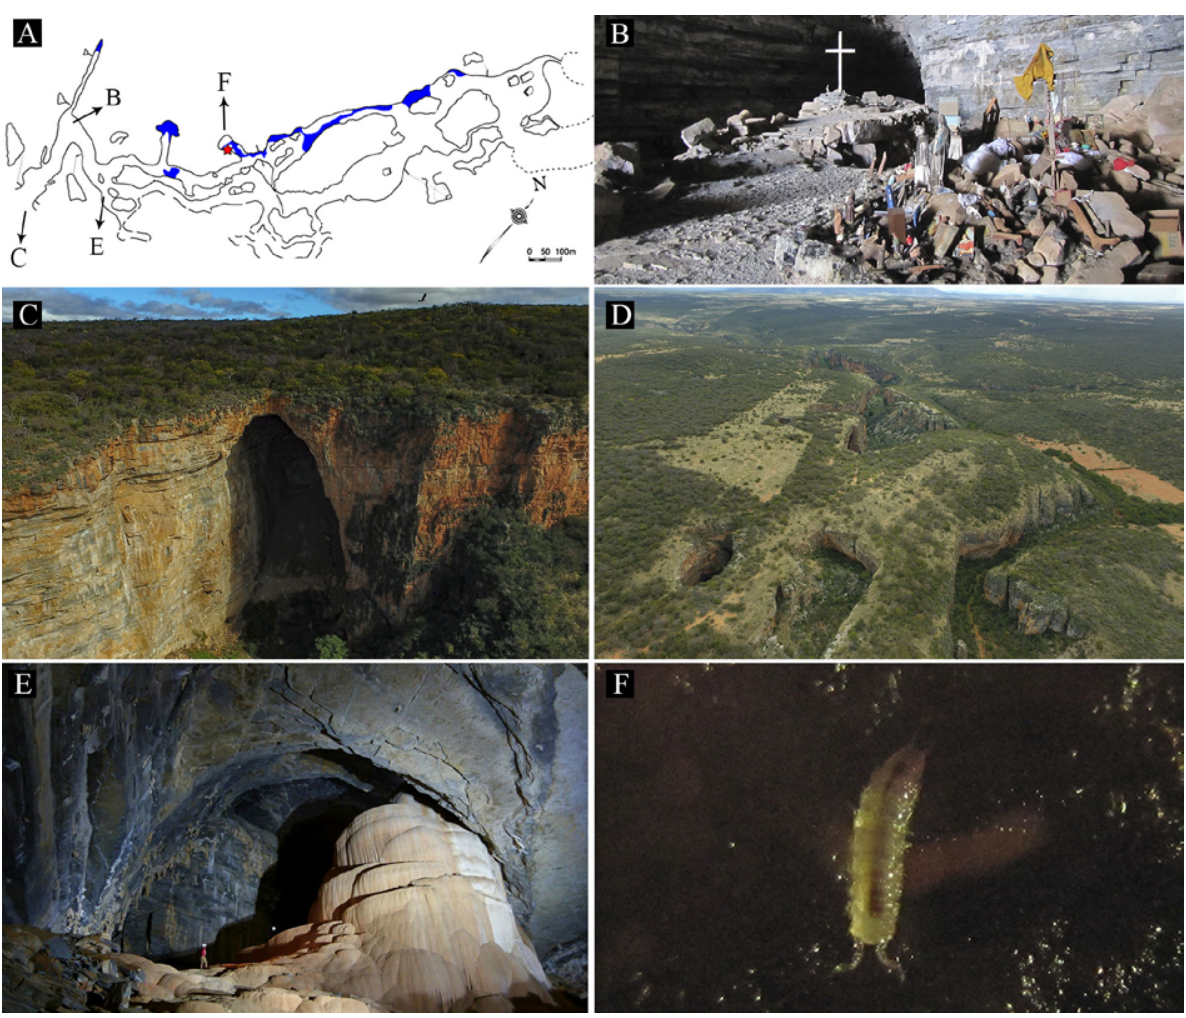
Figure 20. Pectenoniscus morrensis n. sp. A , Gruta dos Brejões cave map, with collecting site; B , religious site in Gruta dos Brejões cave; C , entrance of Gruta dos Brejões cave, outside view; D , aerial photograph of the Permanent Preservation Area of Gruta dos Brejões; E , travertine dams, locally known as “wedding cake” or the “altar”, one of the main speleothems of the cave; F , specimen of Pectenoniscus morrensis n.